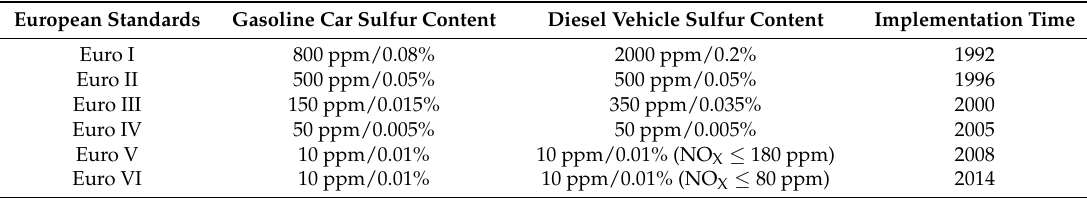
Table 1. European Stage X Motor Vehicle Pollutant Emission Standards